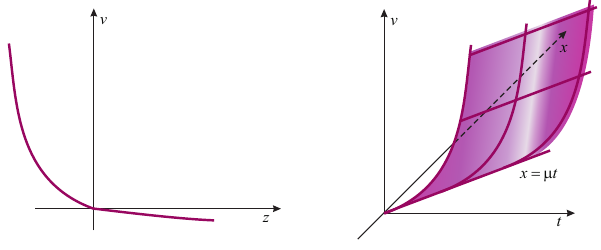
Figure 5. Solution v ( z ) and the diffusion wave.